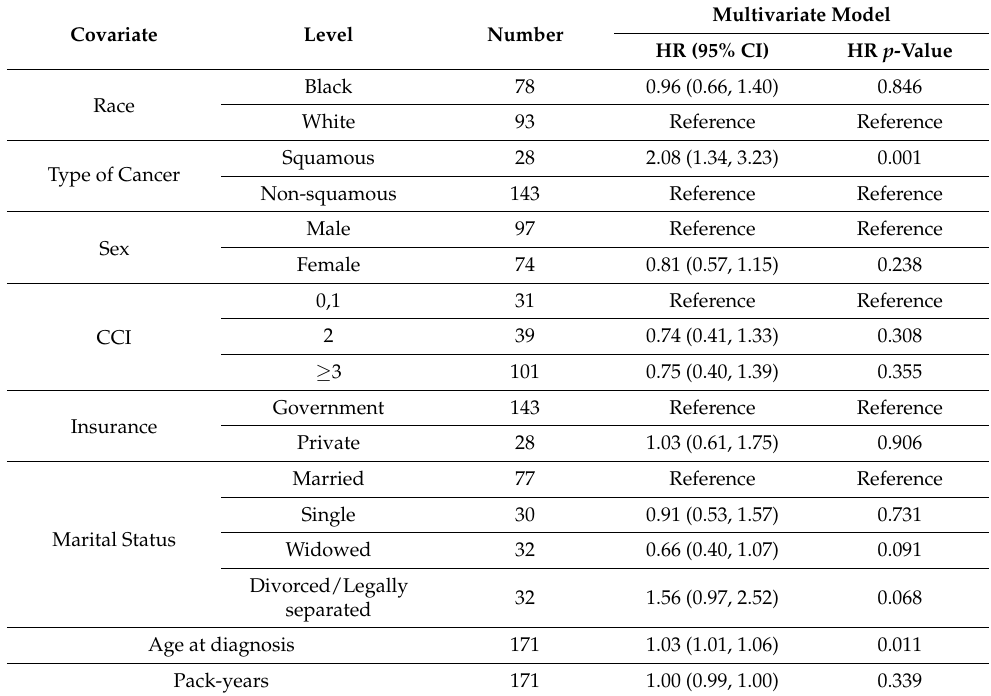
Table 3. Multivariate Association between PFS and Demographic Characteristics of Stage IV NSCLC Patients.